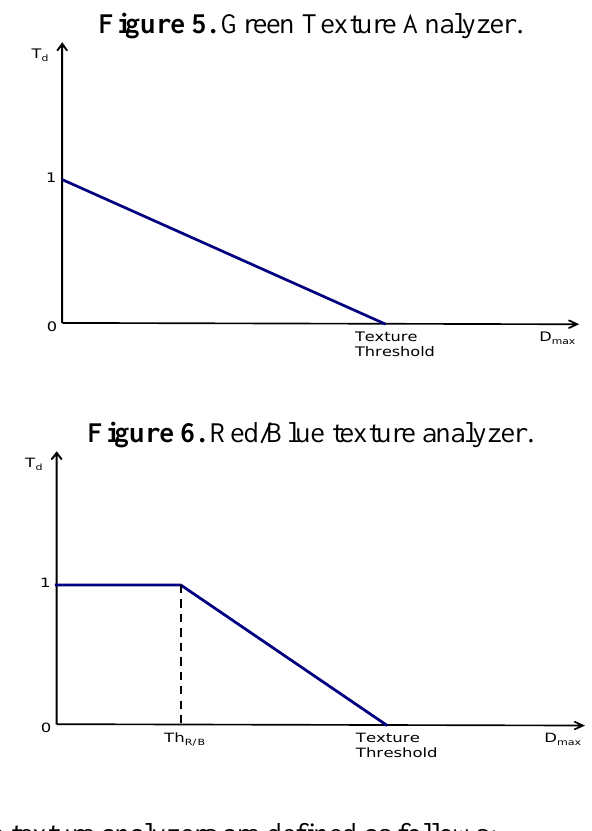
Figure 5. Green Texture Analyzer.